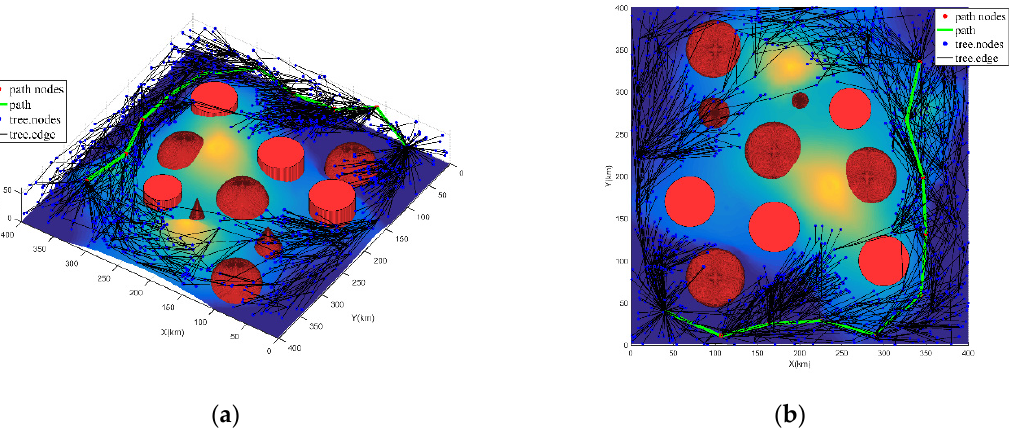
Figure 3. Directed tree graph and path of UAV in Case 1, i.e., λ l =0.1 and λ t = 0.9: ( a ) 3D view of Case 1; ( b ) 2D top view of Case 1.